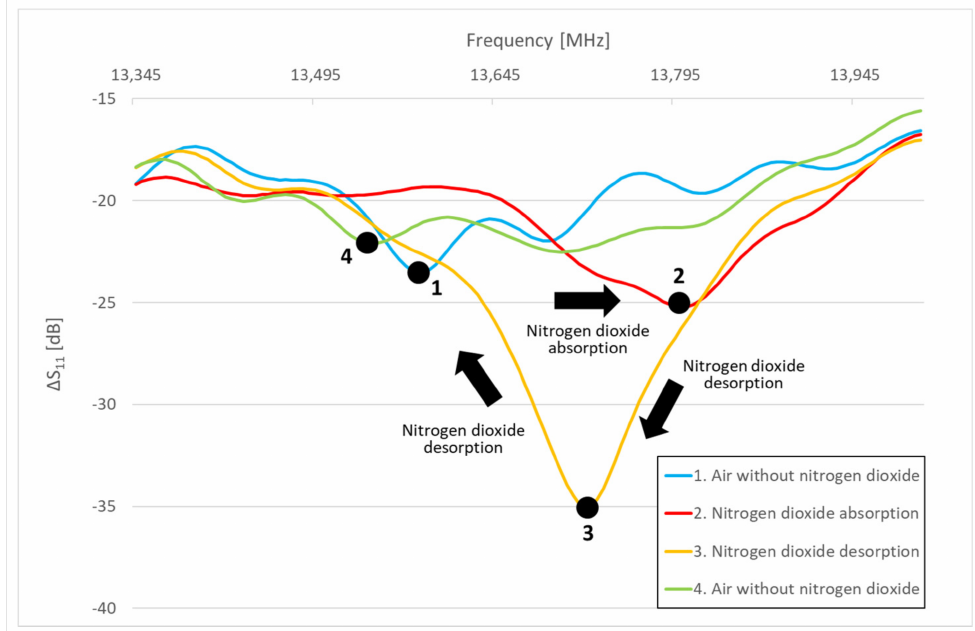
Figure 8. Frequency and amplitude shift in response to the composition of the tested gas